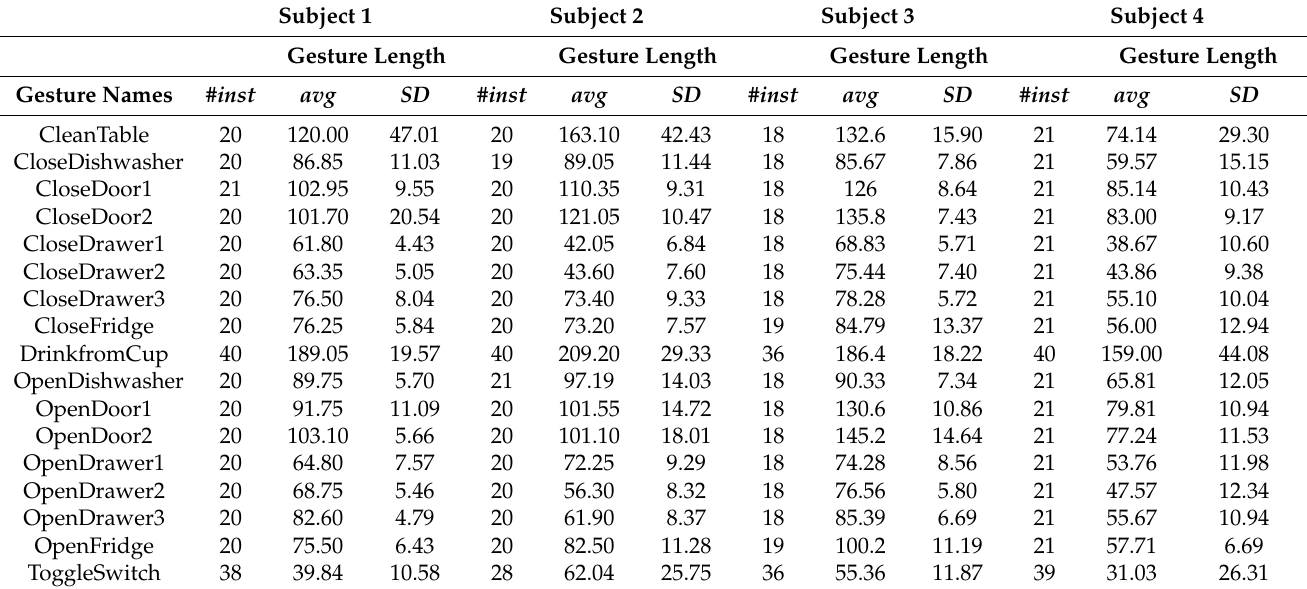
Table 1. Number of instances and average gesture lengths per subject in the Gesture set of the Opportunity